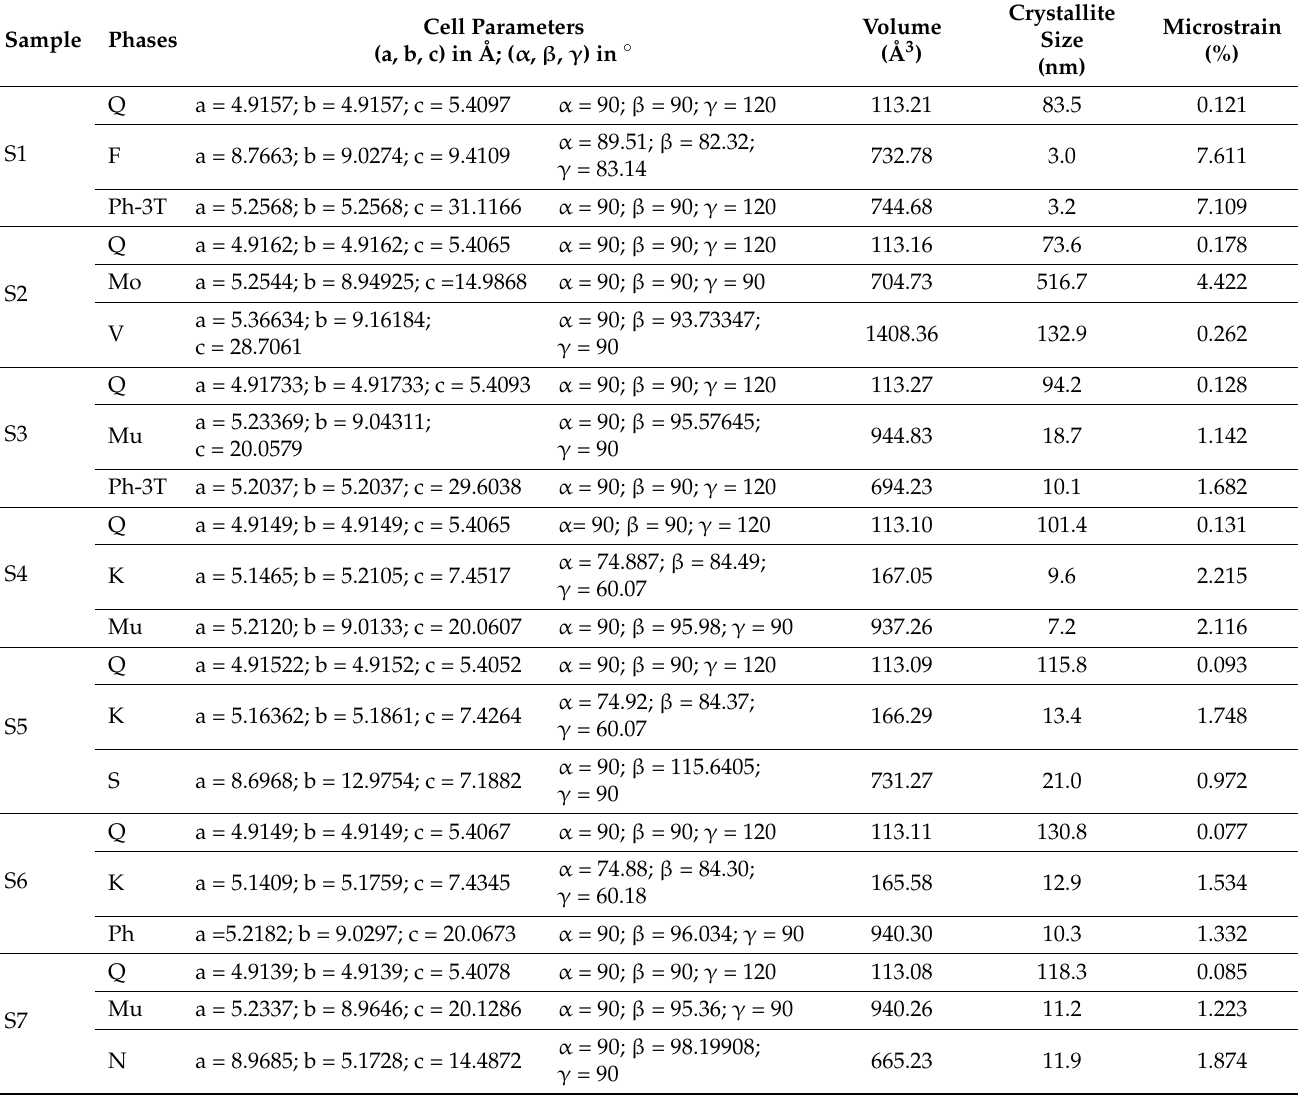
Table 3. Structural parameters of clay samples (S1, S2, S3, S4, S5, S6, and S7) obtained from the Rietveld